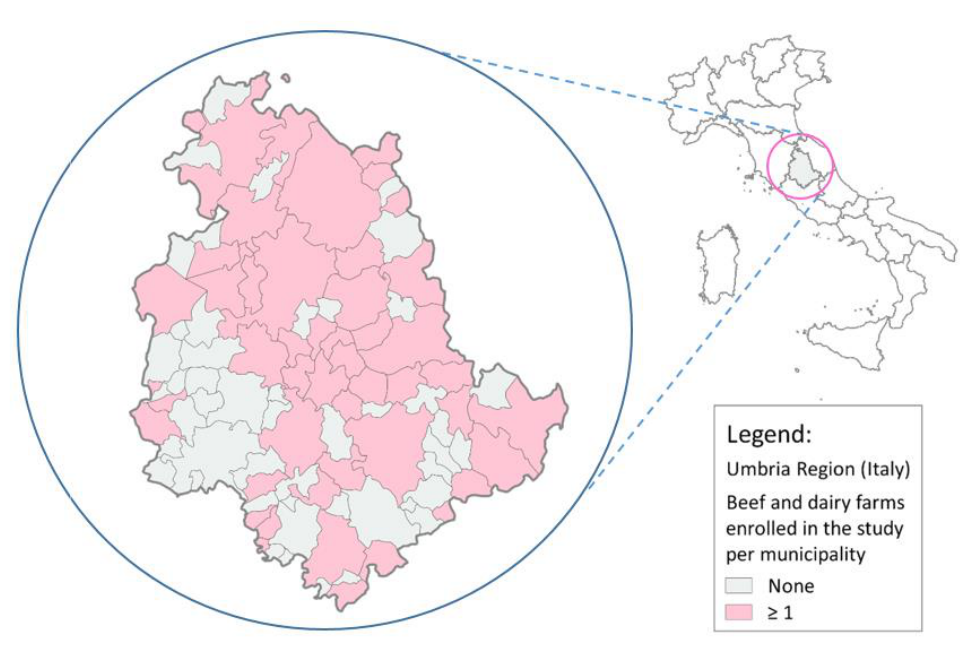
Figure 1. Territorial distribution of sampled farms.